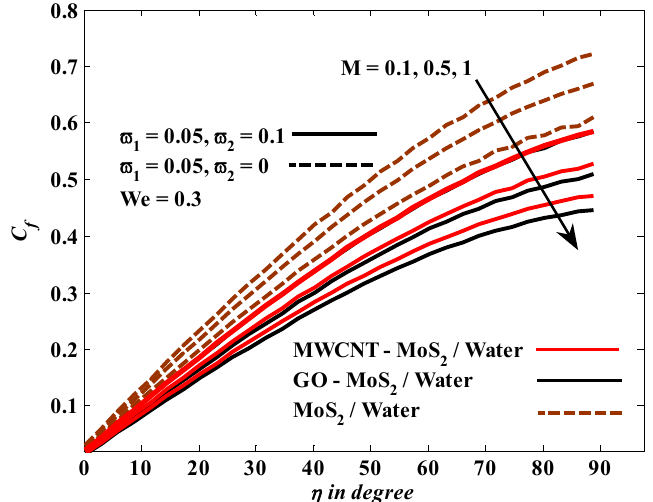
Figure 3. The behavior of hybrid nanofluid’s skin friction under the effect of M.